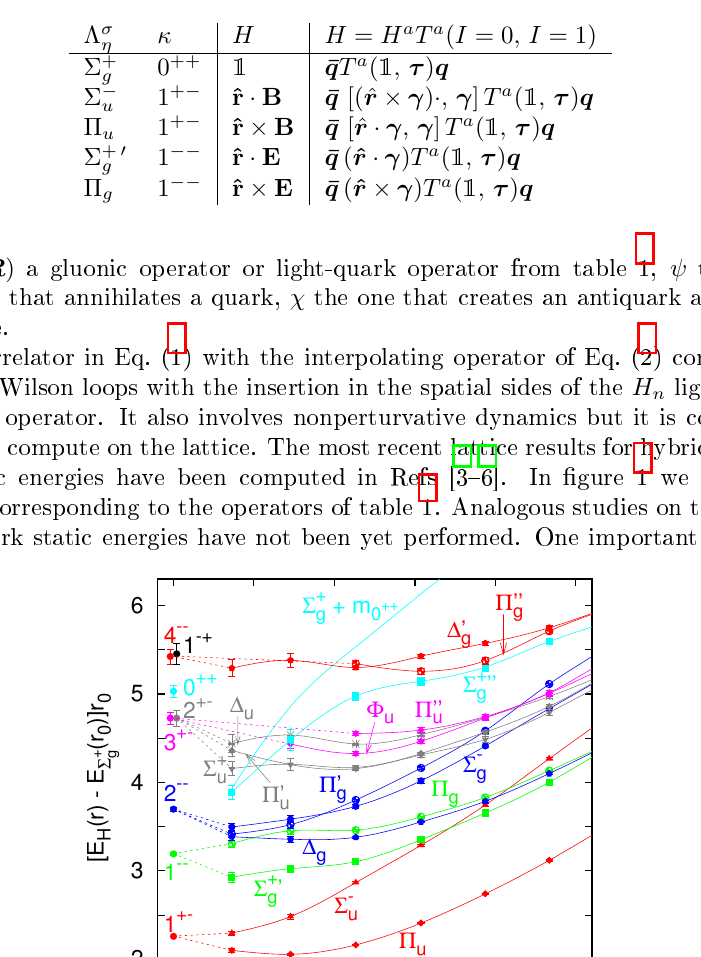
Table 1. Examples of gluonic operators and light-quark operators for quarkonium hybrids and tetraquarks respectively, q = ( u, d ) and τ a are isospin Pauli matrices.